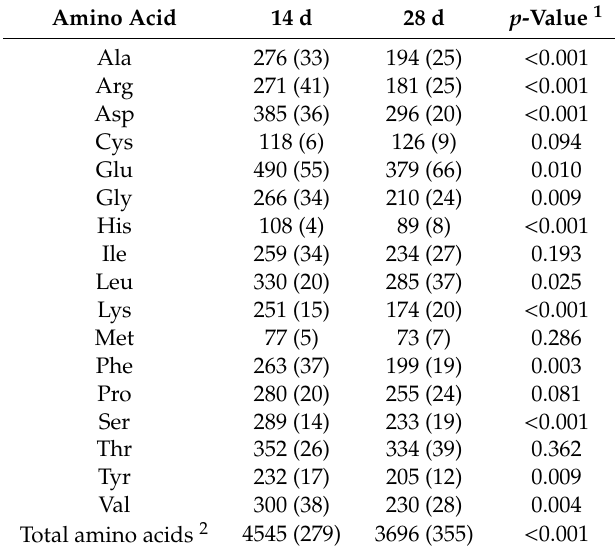
Table 3. Basal ileal flow of endogenous amino acids (mg / kg DMI) in broiler chickens fed the N-free diet at 14 and 28 days age ( n = 6).